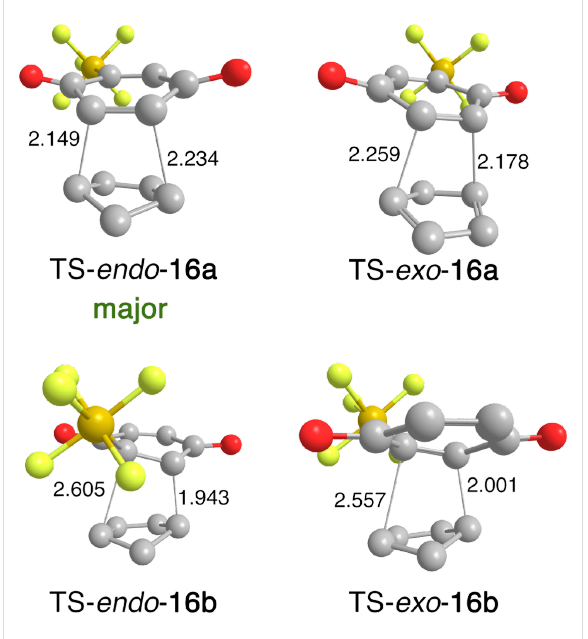
Figure 1: Optimized geometries of transition states of Diels–Alder reaction of cyclopentadiene with 12 . Selected bond lengths are given in